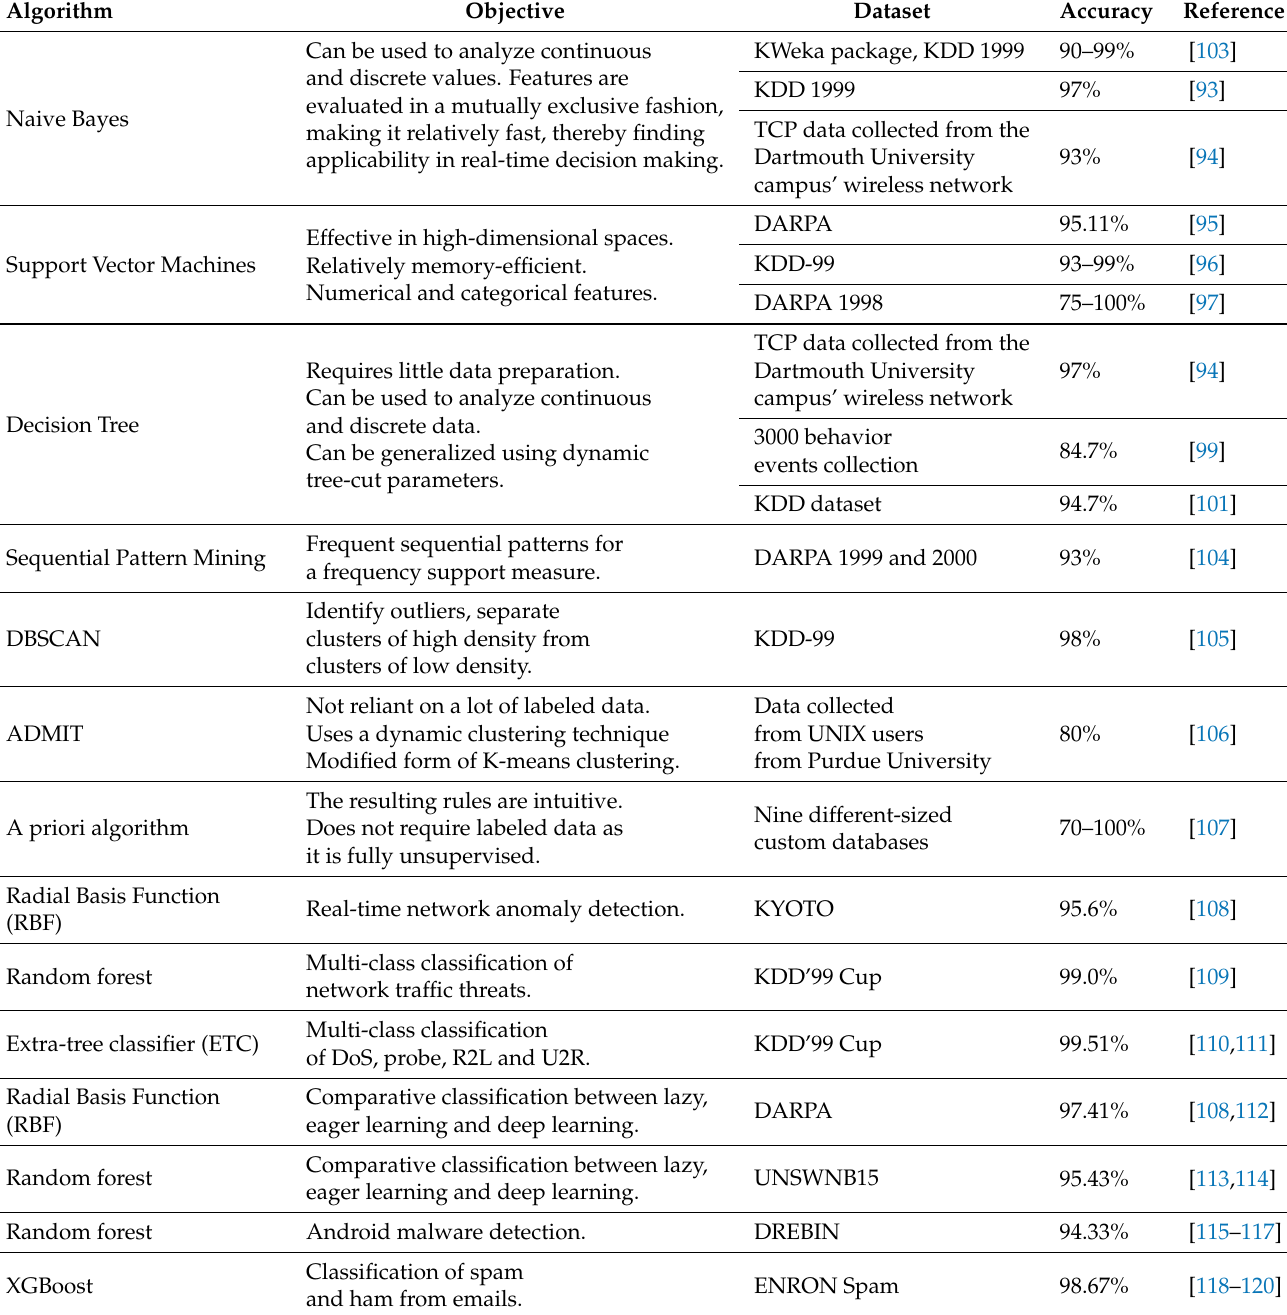
Table 3. Shallow machine learning algorithms Used in